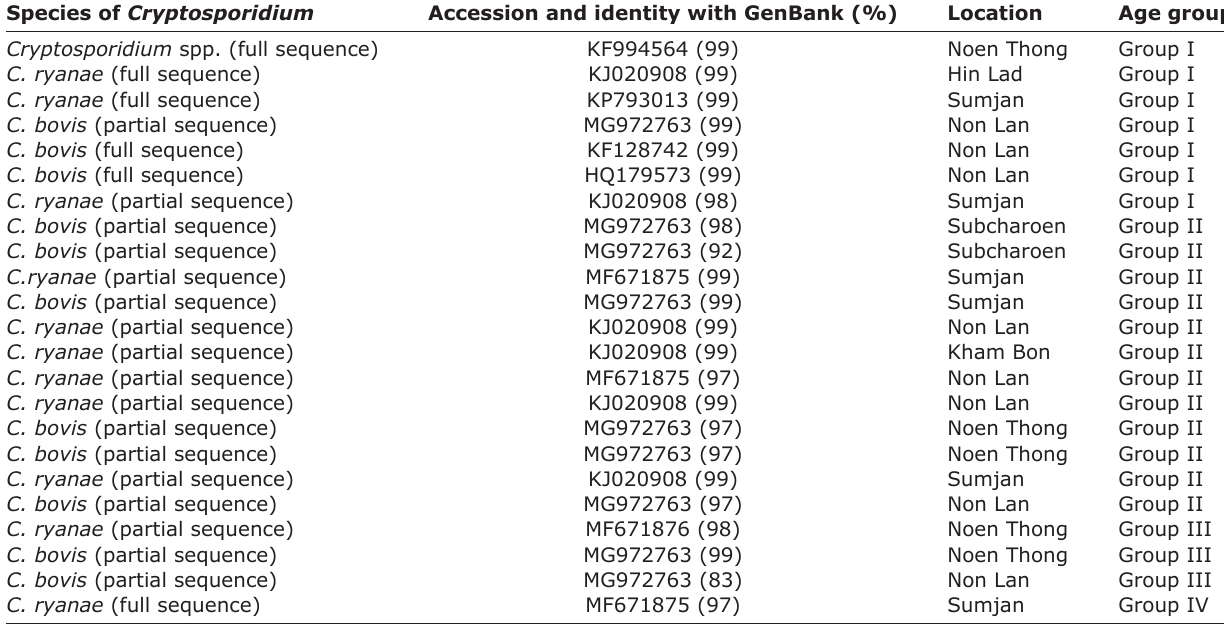
Table-3: Results of genotypic identification of Cryptosporidium spp. and accession against GenBank database. Species of